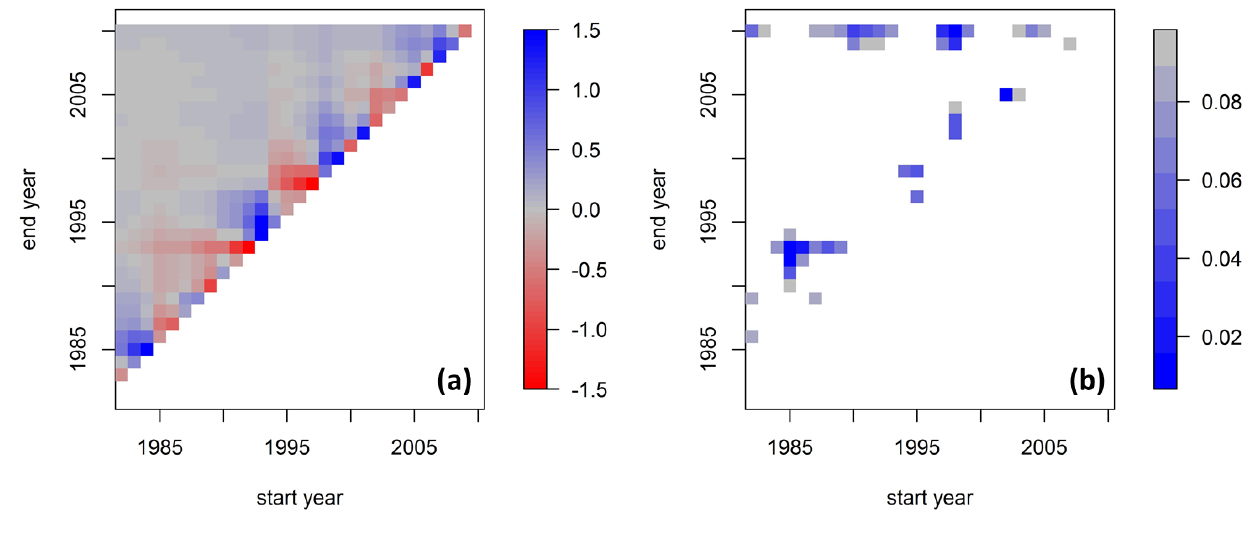
Figure 5. Impact of the start and end of NDVI time series (annual sum) on the strength of the trend that is observed in the Serido. ( a ) The slope of the linear trend (accumulated NDVI/year); ( b ) the significance of the linear trend (only for p <